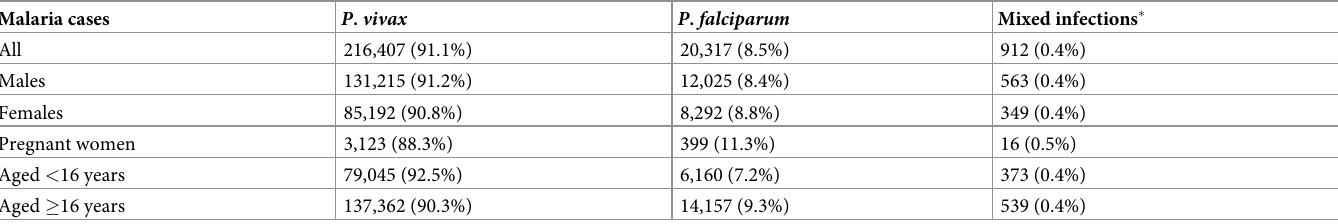
Table 1. Summary of 2018 malaria case reports from the national surveillance system